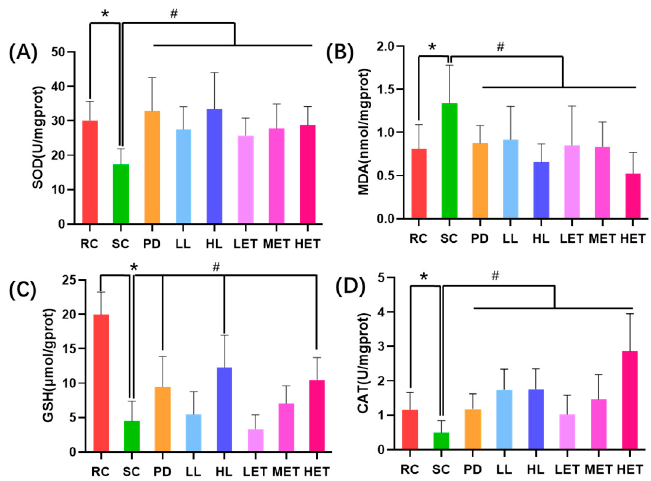
Figure 6. The effects of LBP and LBPT on oxidative stress parameters. ( A ) SOD, ( B ) MDA, ( C ) GSH, ( D ) CAT. Data are expressed as mean ±SD, N = 8, *: vs. RC p < 0.05, #: vs. SC, p < 0.05.